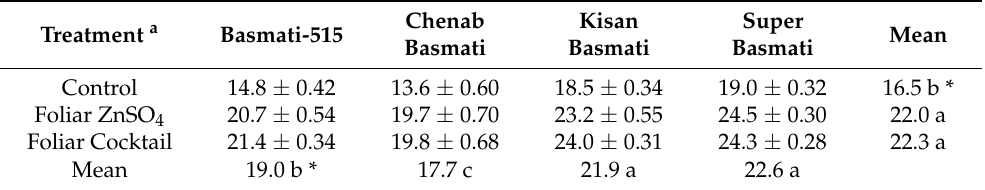
Table 3. Effect of foliar treatments on Zn concentration (mg kg − 1 grain) in brown rice grains of different Basmati cultivars.